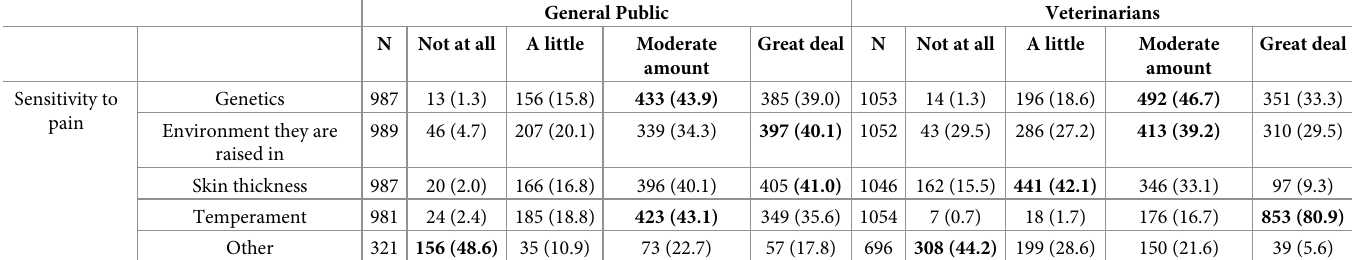
Table 2. Extent to which respondents believed each listed feature influenced sensitivity to pain in dogs. Results are shown for the general public and veterinary respondents. Results are the number of respondents in each category or response, and the percentage of those who rated that factor in parentheses. The highest response percentage for each factor is shown in